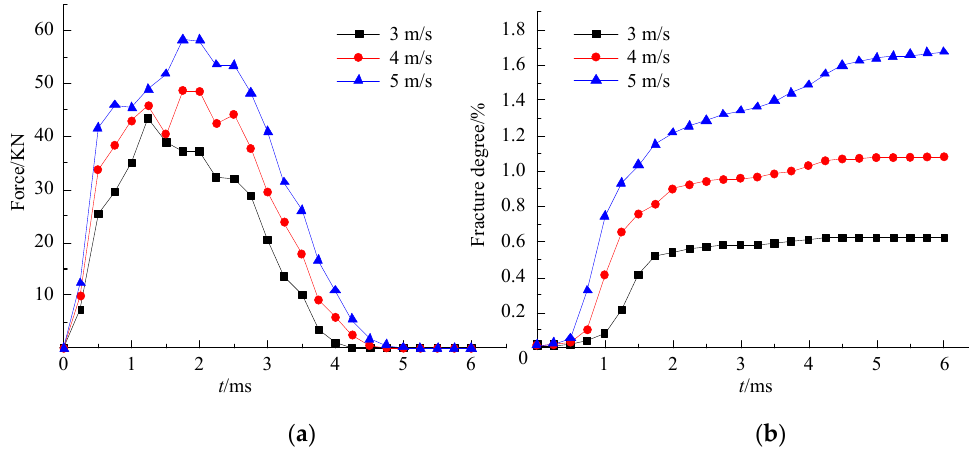
Figure 9. Curves of the impact force and rupture degree under different impact velocities: ( a ) impact-force curves; ( b ) rupture-degree curves.